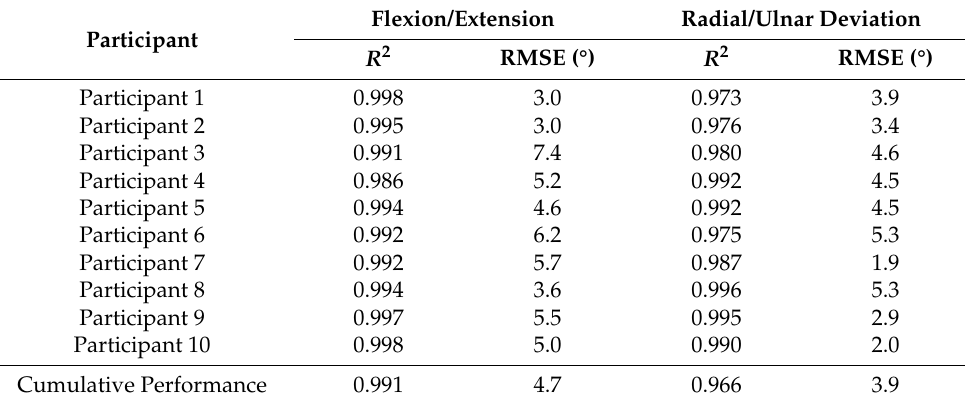
Table 2. Wearable device performance relative to OMC for all subjects. Root mean squared error (RMSE) and the coefficient of determination (R 2 ) are presented for flexion/extension and radial/ulnar deviation. All R 2 are significant ( p < 0.0001). Cumulative performance is calculated across the entire